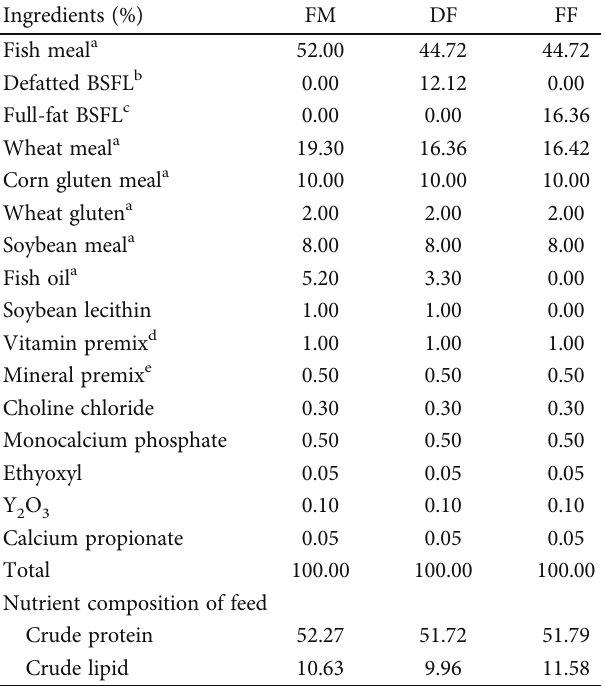
Table 2: Fatty acid composition of three raw materials (% total fatty